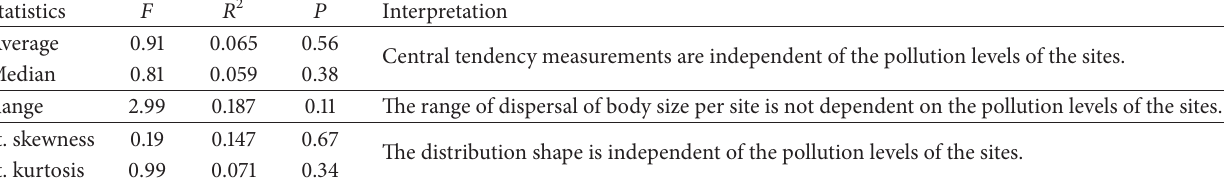
Table 1: The results of linear regression of statistics describing the body size distribution of Lasius niger workers versus pollution level. Five independent analyses were done. None of the statistics were significantly correlated with the metal pollution gradient.